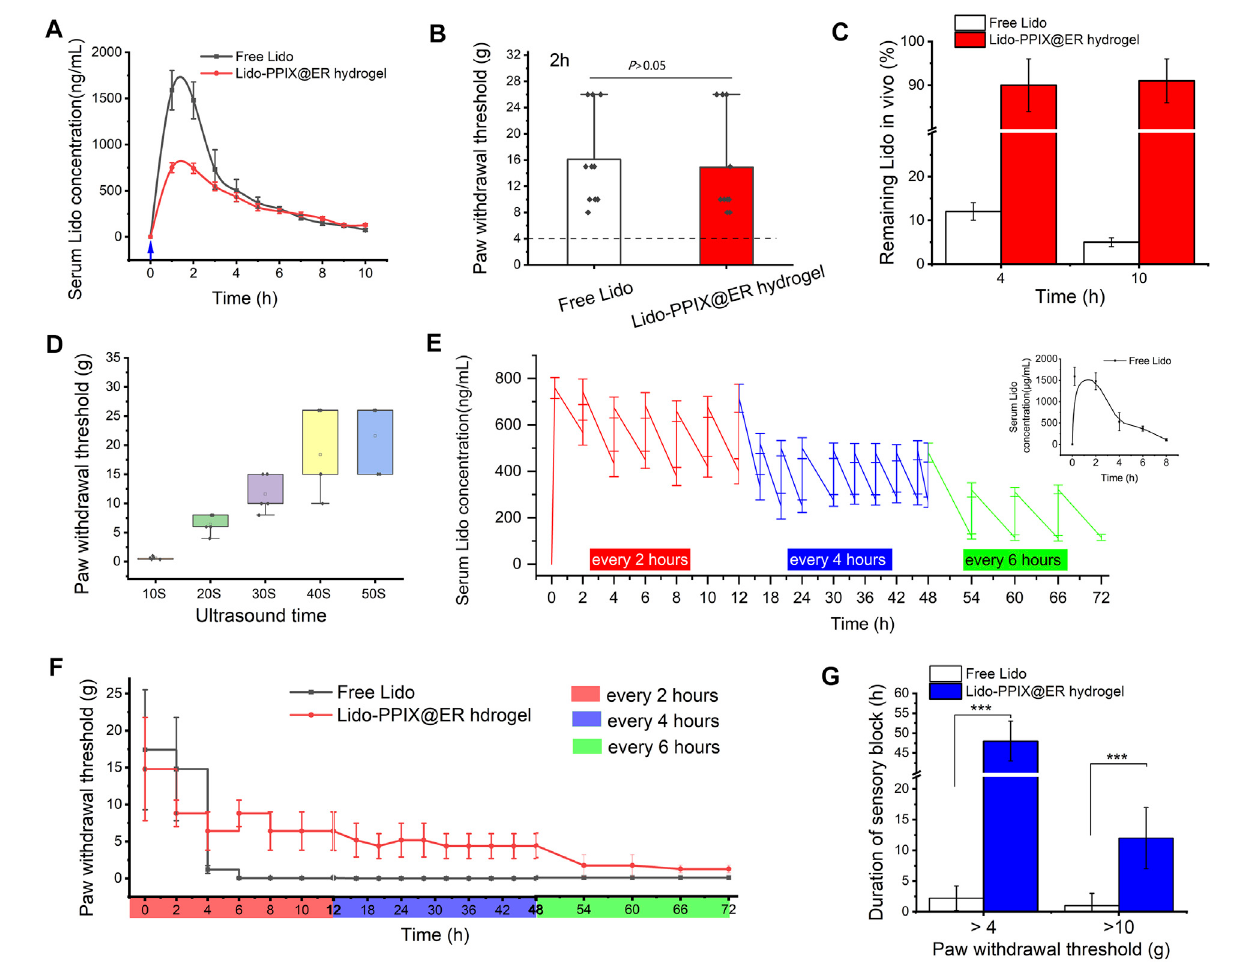
FIGURE6 | Effects of managing postoperative pain invivo . (A) Changecurveofthe serum Lido concentration and (B) paw withdrawal threshold (2 h after surgery) after one ultrasound trigger. (C) Ratio of the remaining lidocaine in free lidocaine and Lido-PPIX@ER hydrogel after one ultrasound-triggered removal from the administration site in rats. (D) Duration of ultrasound-triggered lidocaine release and effect of pain relief application in the rat model of postoperative pain in the Lido- PPIX@ER hydrogel-treated group. (E) Change curve of the serum Lido concentration and (F) the hind paw withdrawal thresholds after on-demand ultrasound triggering in the Lido-PPIX@ER hydrogel group (triggered for every 2 h in the fi rst 12 h and every 4 h for the next 36 h, and then every 6 h until 72 h after surgery). (G) Effective time at different paw withdrawal thresholds in the ultrasound-triggered Lido-PPIX@ER hydrogel group. ***, p < 0.001.